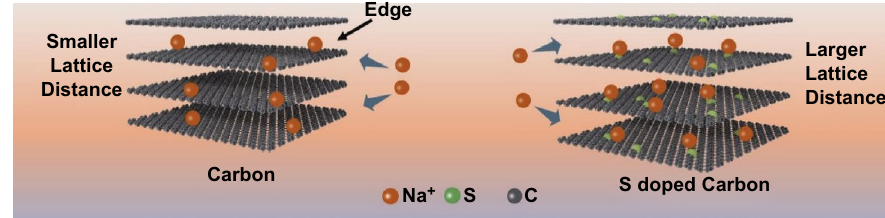
Fig. 5 Possible Na-ion storage mechanism for